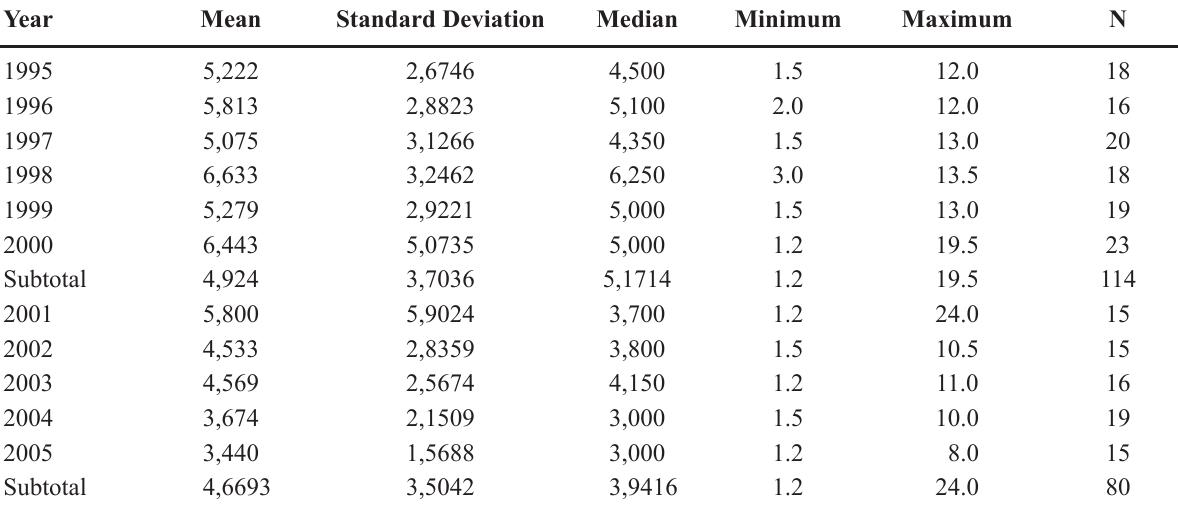
Table 2 – Size of tumors.